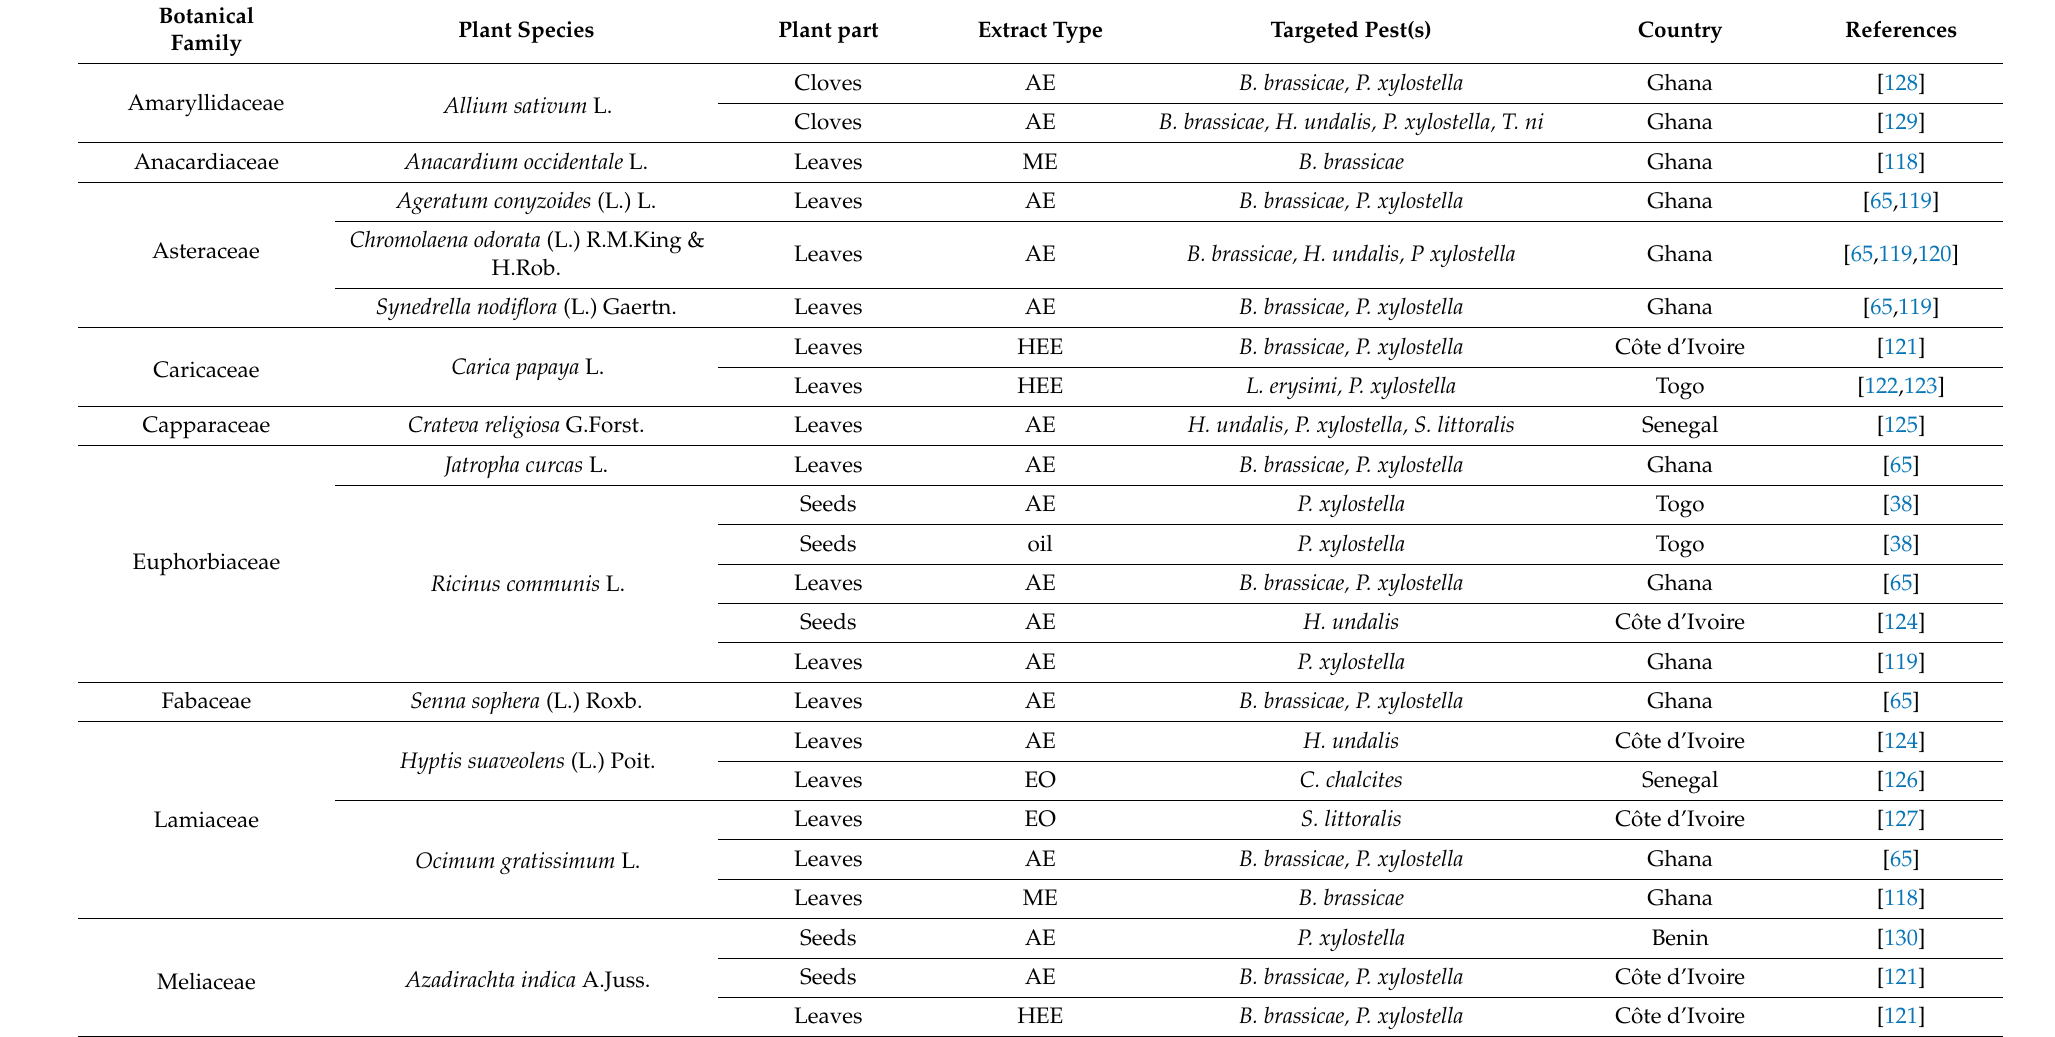
Table 3. Plant species tested or currently used for the management of the insect pests affecting cabbage in West Africa.